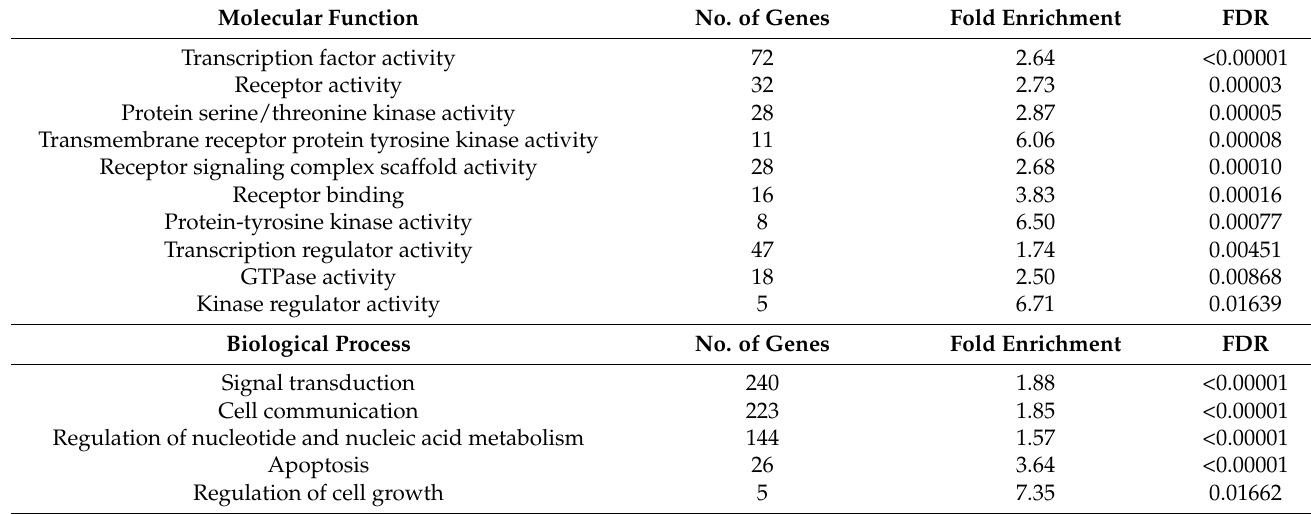
Table 4. Functions associated with genes regulated by exosome miRNAs common in lung cancer signatures. Molecular